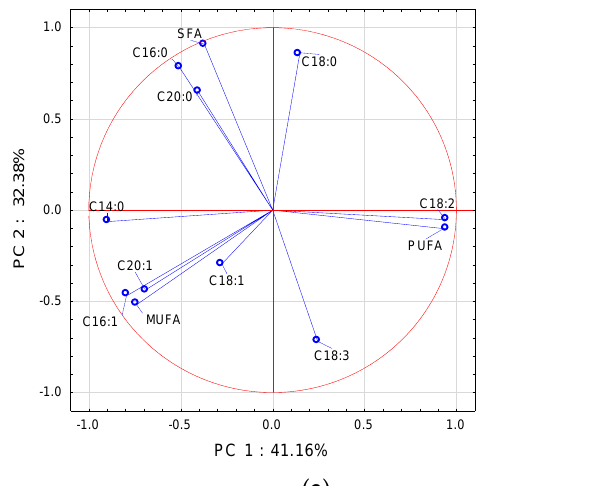
Figure 2. Projections of the ( a ) variables (fatty acids) and ( b ) scores (plant extracts) for raw pork meat samples onto the factor plane defined by principal components (PC1 and PC2).